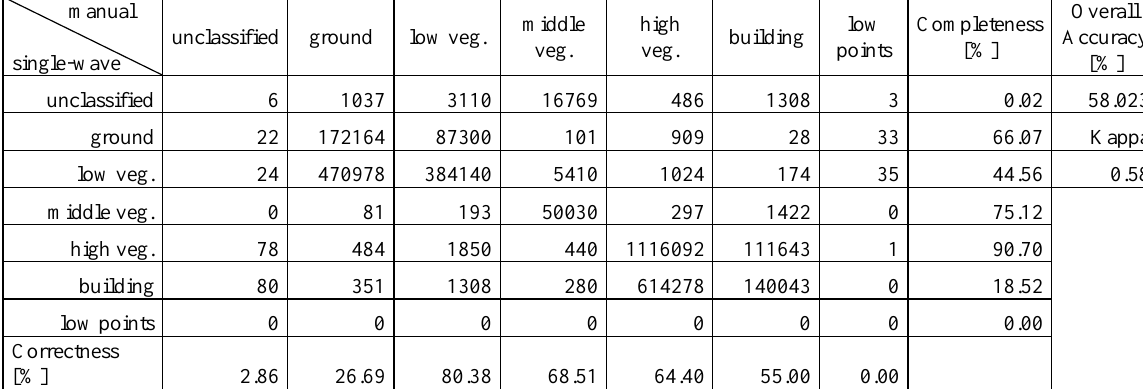
Table 3 Confusion matrix and accuracy estimates for the single-wavelength classification manual